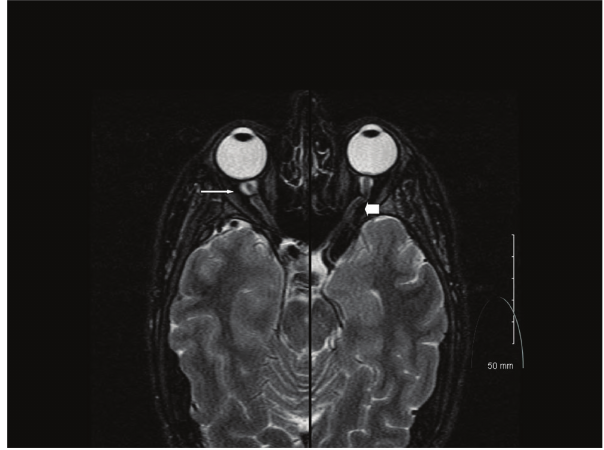
Figure 2: MRI of optic nerves. Merged axial T2 MRI at the level of the optic nerves shows significantly increased optic nerve sheath expansion near the globe (thin arrow), which extends through the course of the optic nerve sheath (thick